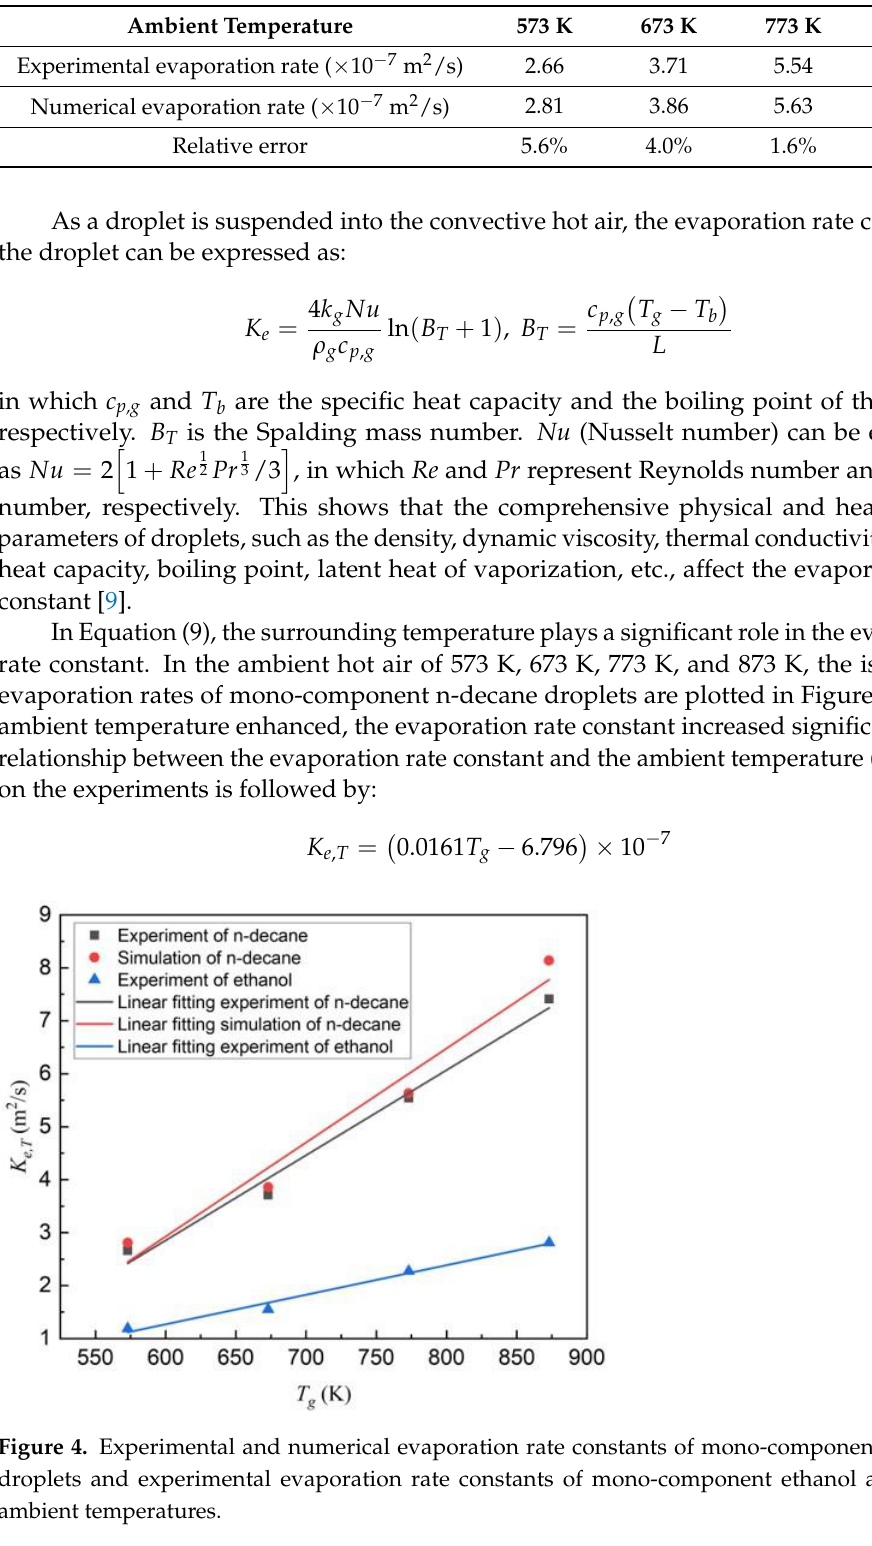
Table 2. Experimental and numerical results of mono-component n-decane droplet evaporation in the hot air of different temperatures.